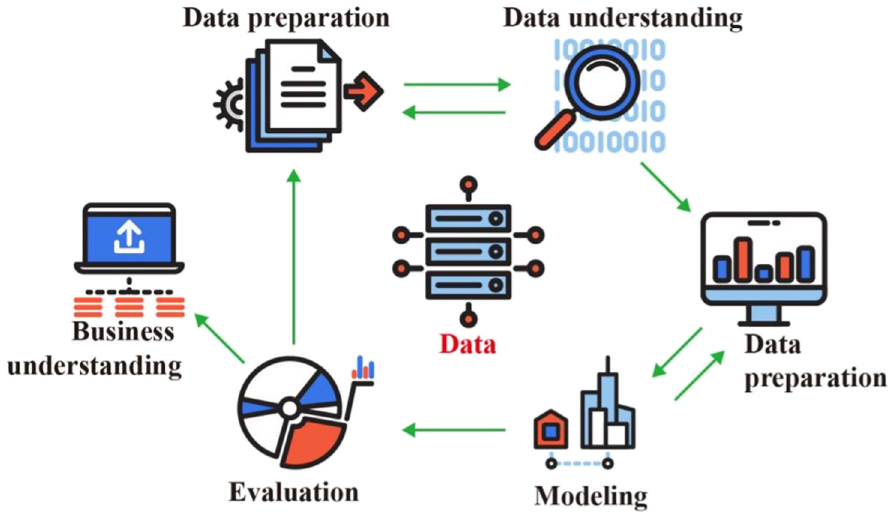
Figure 1: The process of data